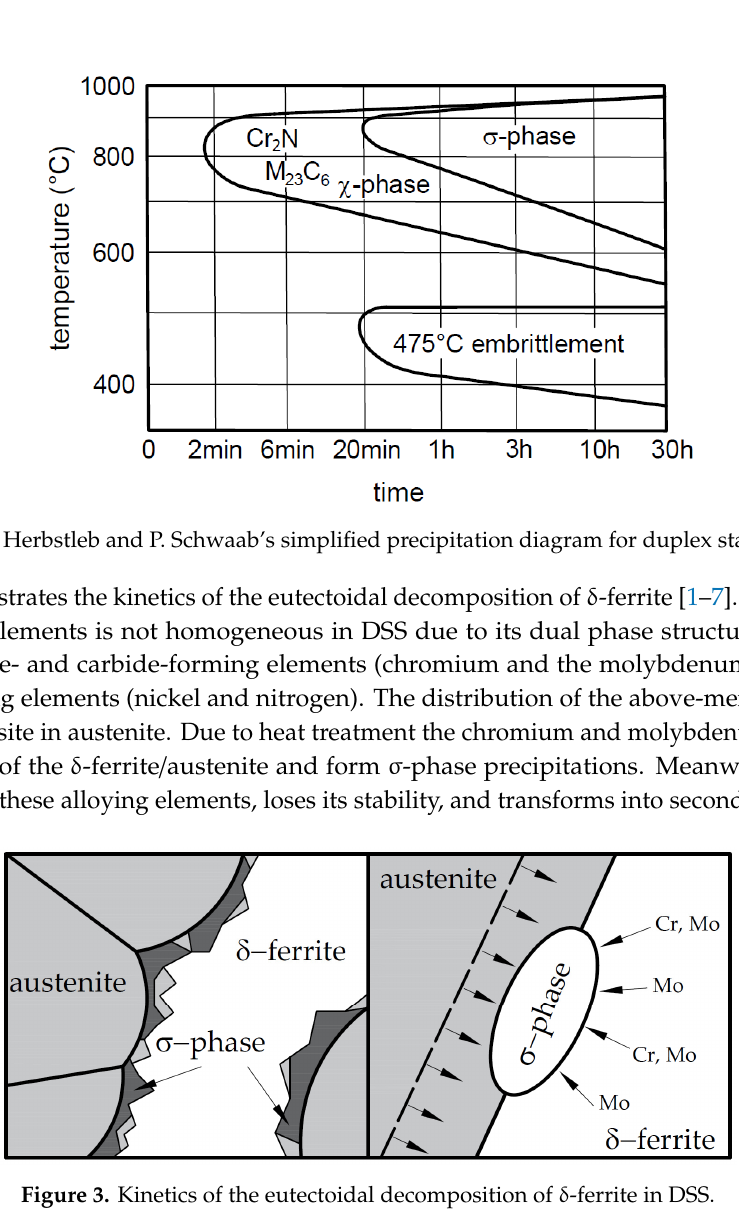
Table 2. Chemical composition of the 2507-type SDSS (%).